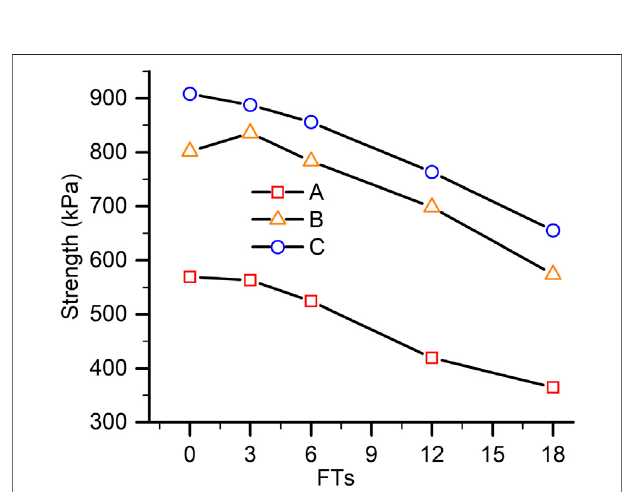
FIGURE 3 | Strain-stress curves S/S sediments in FTs: (A) Proportion A, (B) Proportion B, (C) Proportion C.